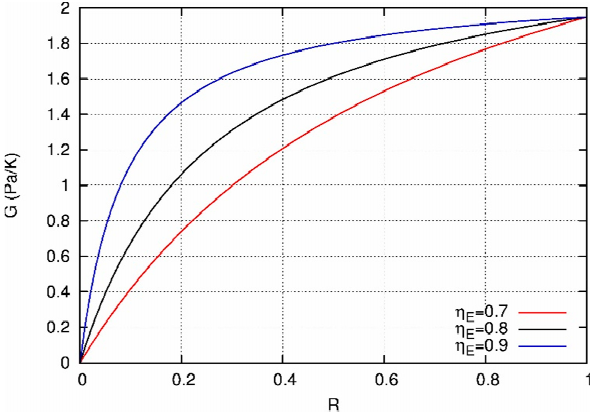
Figure 5. Dependence of the contrail factor G on the ratio R for parallel-hybrid-electric propulsion. 𝑅 = 1 is full fuel propulsion, 𝑅 = 0 is full electric propulsion. Parameters for the calculation have been 𝜂 (cid:3012) = 0.4 , Q=43.2 MJ/kg, 𝑝 (cid:3028) = 250 hPa, and 𝑄 (cid:3006)(cid:2868) = (𝜂 (cid:3012) 𝜂 (cid:3006) ⁄ )𝑄 .